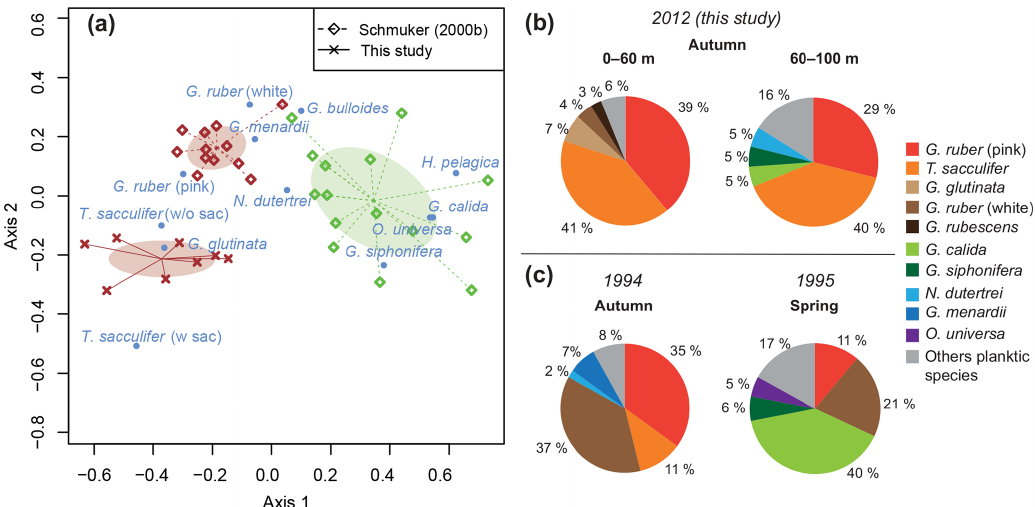
Figure 6. Comparison of planktic foraminiferal assemblages between spring (1995) and autumn (1994, 2012). (a) Optimal NMDS ordination (Wisconsin double-standardized relative abundances, Bray–Curtis similarity index) of planktic foraminifers during spring (green) and autumn (brown) 1994/1995 (Schmuker, 2000b), and autumn 2012 (this study). Ellipses indicate standard deviation of assemblages around the centroid of the groups. (b) Average assemblage composition of planktic foraminifers at stations 1 and 2 in 2012. Percentages were calculated from the total living planktic assemblage of the sampling intervals 0–60 and 60–100m water depths. (c) Average assemblage composition of planktic foraminifers from autumn 1994 and spring 1995, mesh size > 150µm (Schmuker,